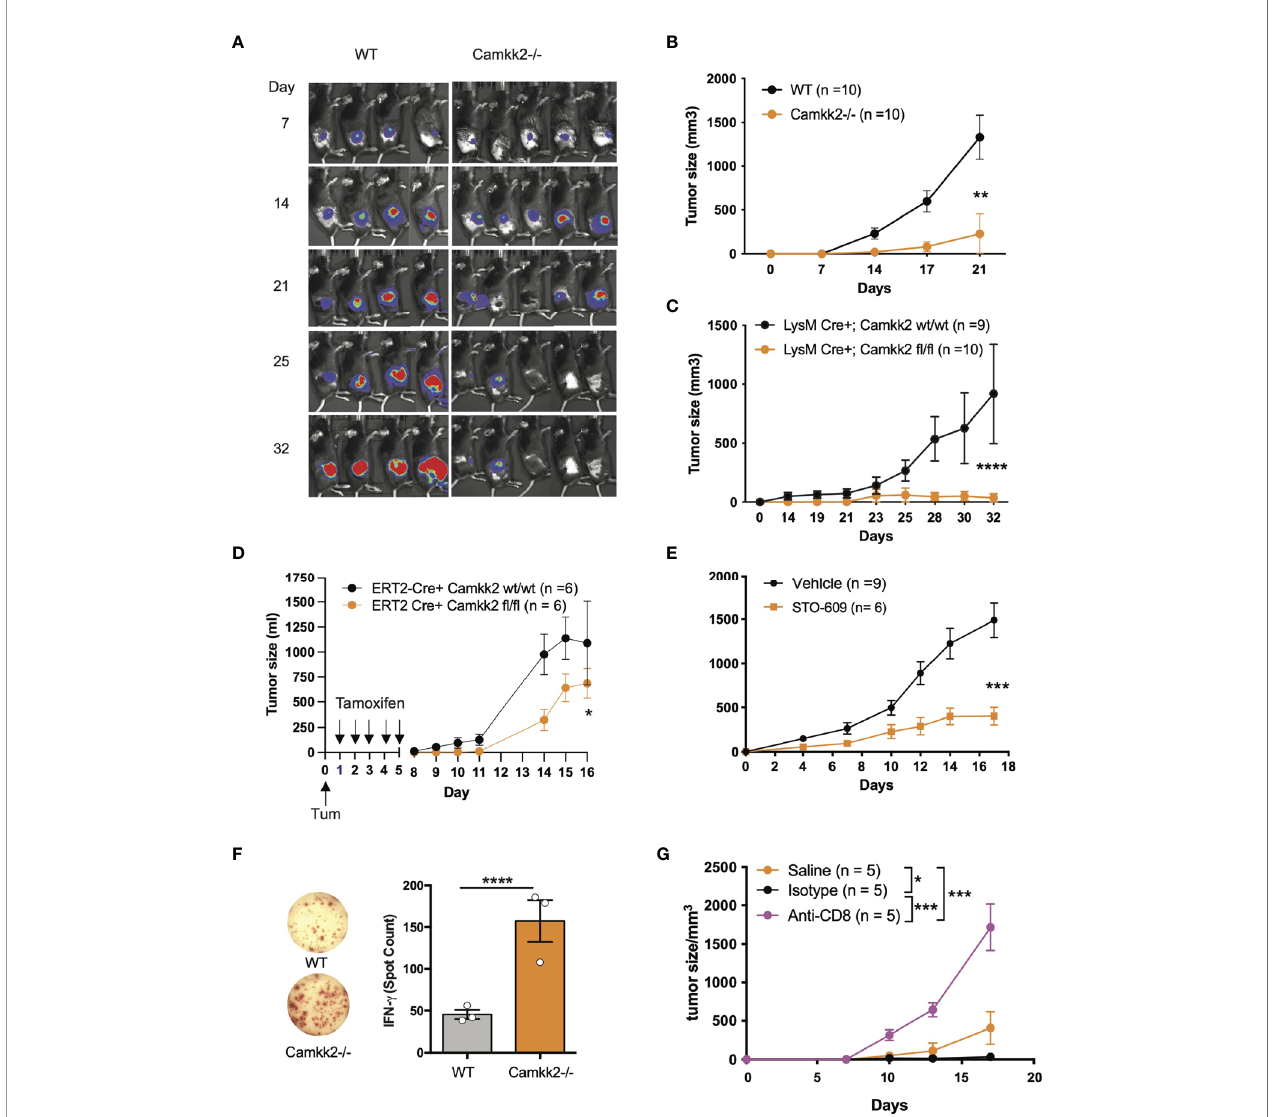
FIGURE 1 | Deletion of Camkk2 in the host inhibits lymphoma cells growth. WT and Camkk2 -/- mice were injected with E.G7-OVA s.c. in the fl ank. The tumors were measured every 3-4 days. (A) Bioluminescent imaging of tumors growing in WT and Camkk2 -/- mice (1×10 4 cells/mouse). (B) Tumors size in WT and Camkk2 -/- mice (1×10 5 cells/mouse). N = 10 mice/group. Repeated twice. (C) Tumors size in LysM-Cre+; CaMKK2 wt/wt and LysM-Cre+; CaMKK2 fl / fl mice (5×10 5 cells/mouse). N